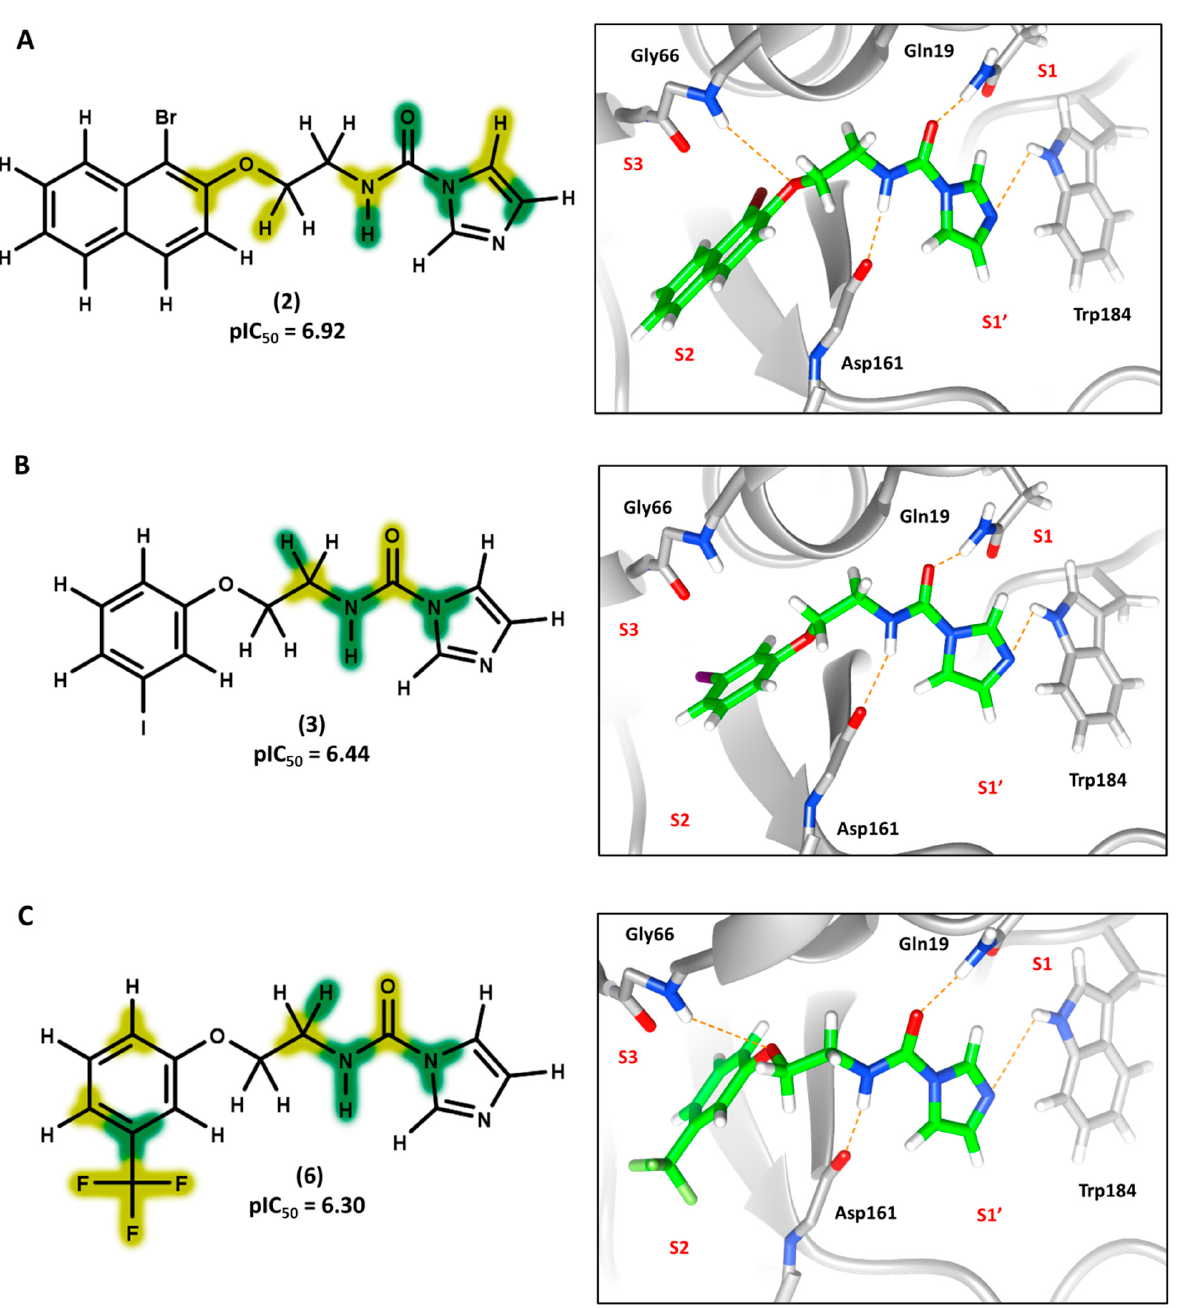
Figure 5. Contribution maps showing the key role played by the imidazole, linker, and aryl halide fragments in activity and binding conformations predicted by molecular docking. ( A ) Compound 2; ( B ) compound 3; ( C ) compound 6. Inhibitors and active site residues are depicted as sticks, and hydrogen bonds are shown as dashed lines. Contribution maps: Yellow and green represent positive contributions, while red, orange, and red-orange indicate negative contributions to activity. White represents intermediate